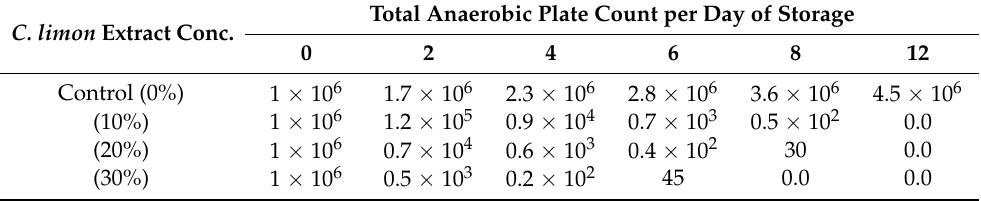
Table 9. Storage study and shelf-life evaluation of tuna meat during refrigerated storage after treatment under different concentrations (10%, 20%, and 30%) of limon leaf extract. C. limon Extract Conc.